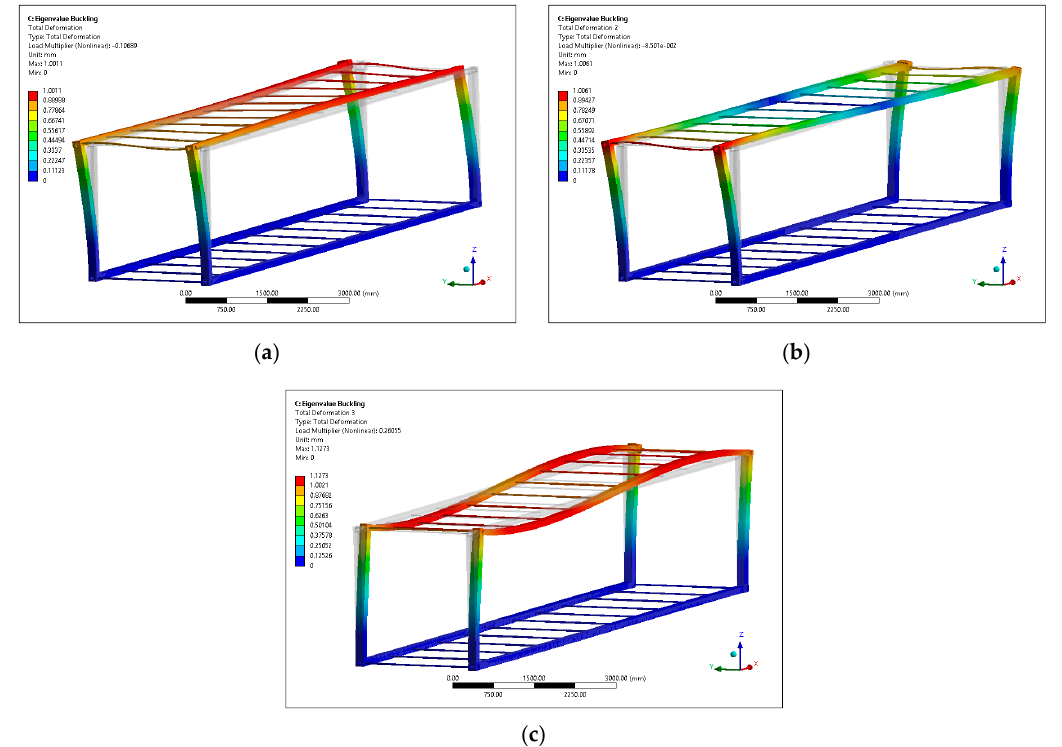
Figure 8. Each corner is under ~100 tons of load and the phenomena is exaggerated 320 times. ( a ) Buckling mode 1, ( b ) buckling mode 2, and ( c ) buckling mode 3.